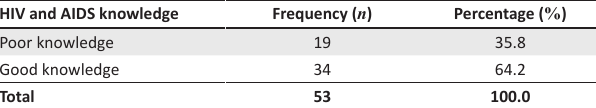
TABLE 2: Overall HIV and/or AIDS knowledge. HIV and AIDS